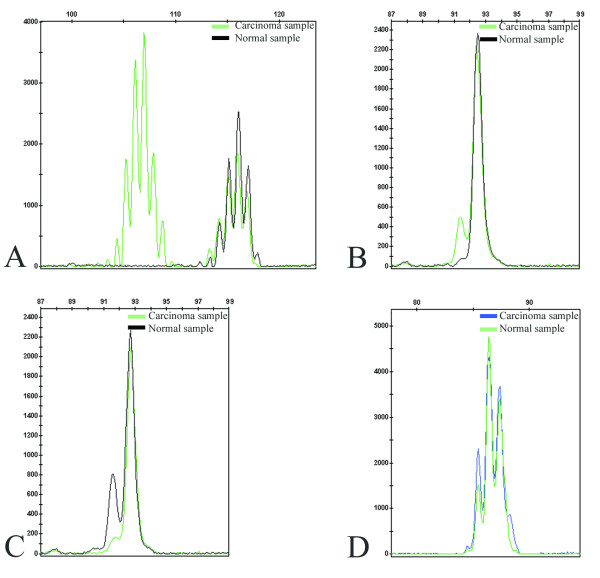
Fragment analysis electrophorograms showing microsatellite sequences of BAT26 (A), IGF2R (G8) (B), BAX (G8) (C), and TGFBR2 (A10) (D) in a rectal carcinoma (T41). Microsatellite instability was found in BAT26, IGF2R, BAX, but not in TGFBR2.